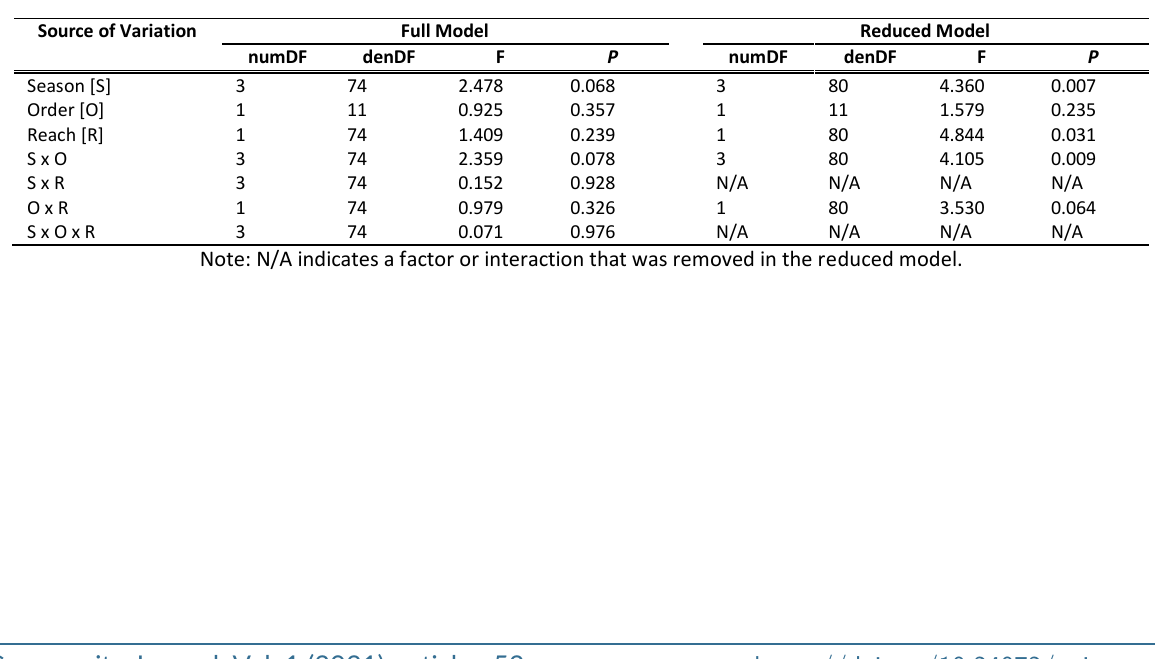
Table 3 : ANOVA results for the full and reduced models of taxonomic richness proposed by Swan and Brown (2017, 2018). Models were fitted using restricted maximum likelihood and with Type III sums-of- squares for estimating main and interactive effects of factors. The unpaired sample was not removed from the data prior to fitting the full and reduced model